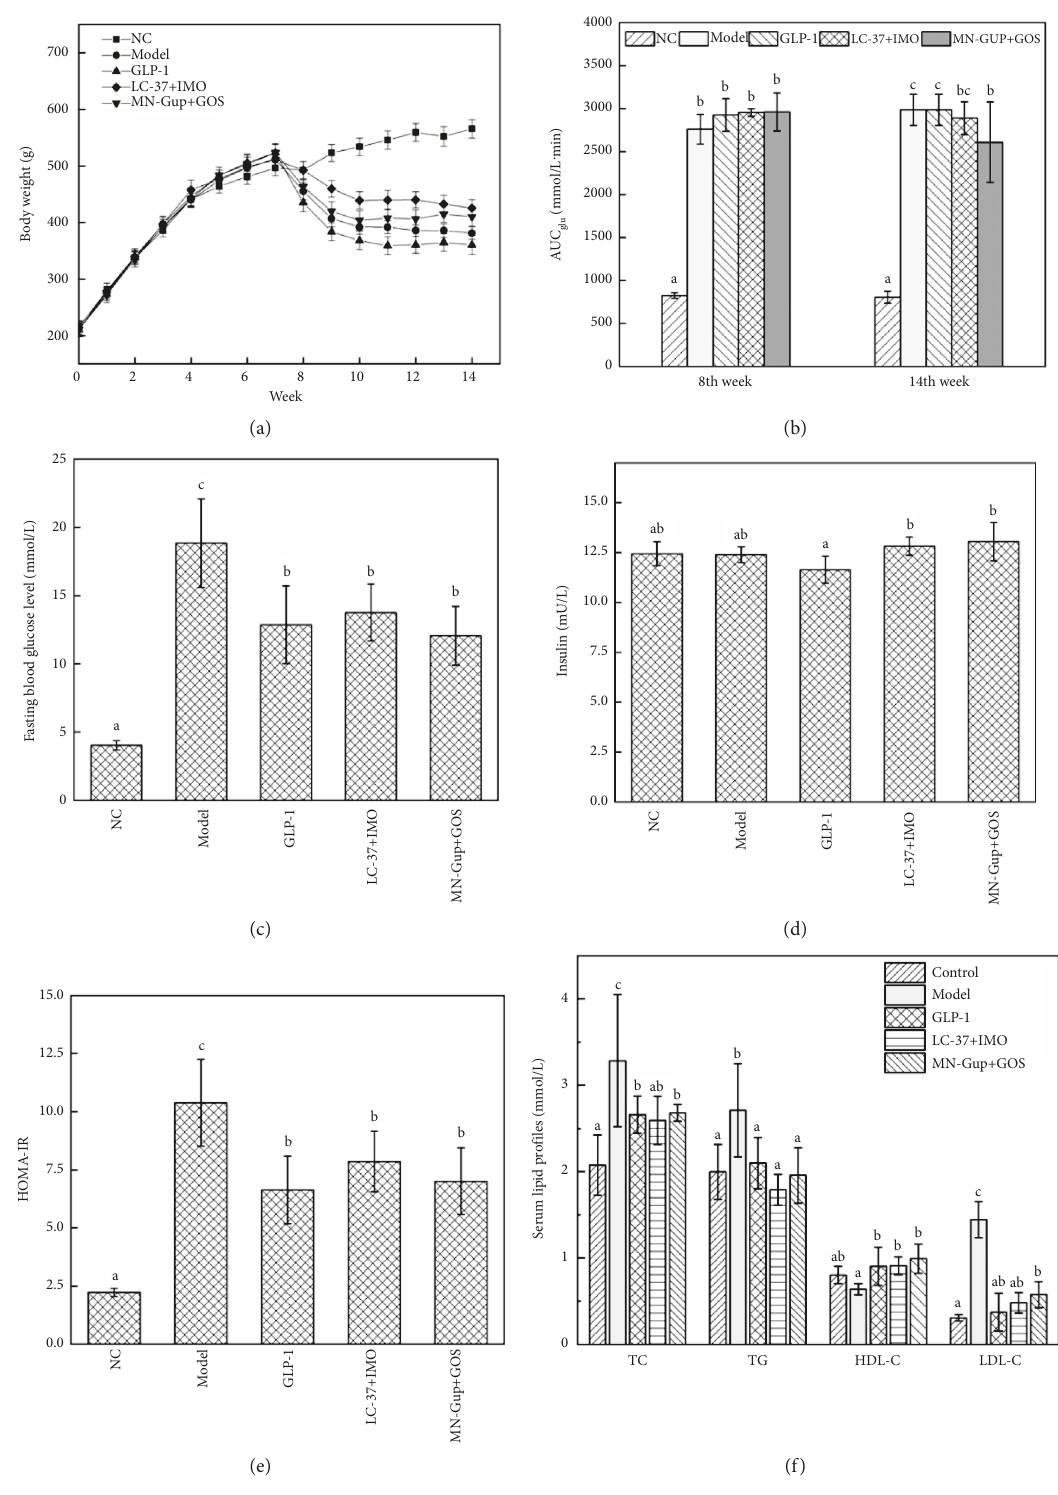
Figure 5: Effects of LC-37 and MN-Gup with prebiotics on (a) body weight, (b) glucose tolerance assessed by oral glucose tolerance test (OGTT), (c) fasting blood glucose level, (d) insulin level, (e) HOMA-IR, and (f) serum lipid profiles in HFD/STZ-treated rats. Data are shown as means ± standard deviations (SD), and different lowercase letters indicate significant differences, p < 0 . 05 ( n �